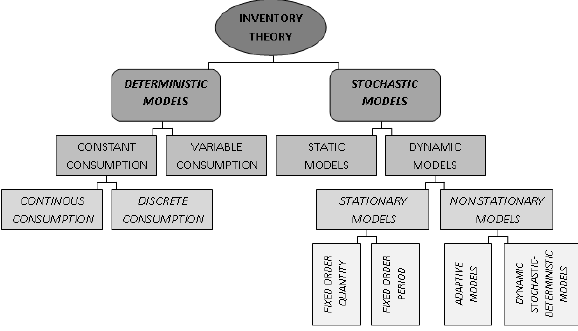
Figure 1: Mathematical models in the field of inventory theory